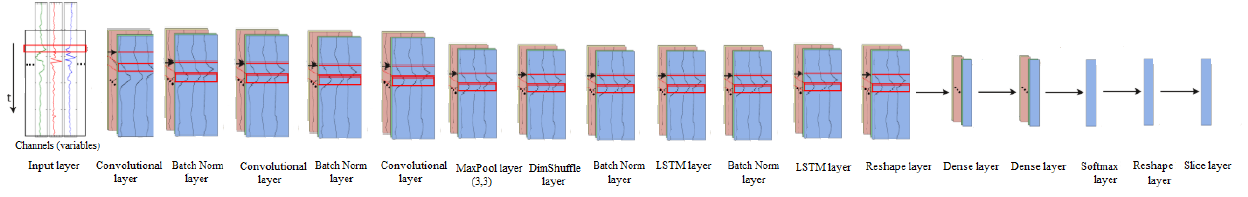
Figure 11. Architecture of the CNN-LSTM model for ice-jam prediction (adapted after Ordóñez and Roggen, 2016).